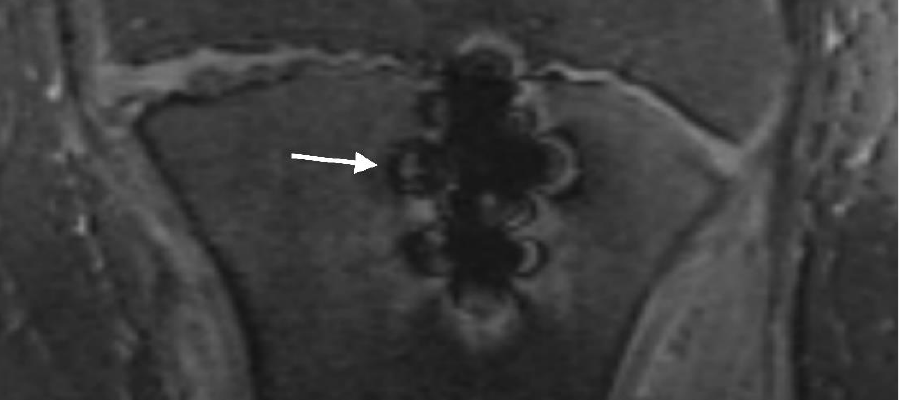
Figure 7. T2 trufi 3d we (true fast imaging with steady-state free precession three-dimensional water excitation) coronal image of the tibia of a 12-year-old boy with a tibial tuberosity fracture showing curvilinear hyperintense signals alternating with bands of signal loss (pile-up artifact) (arrow).